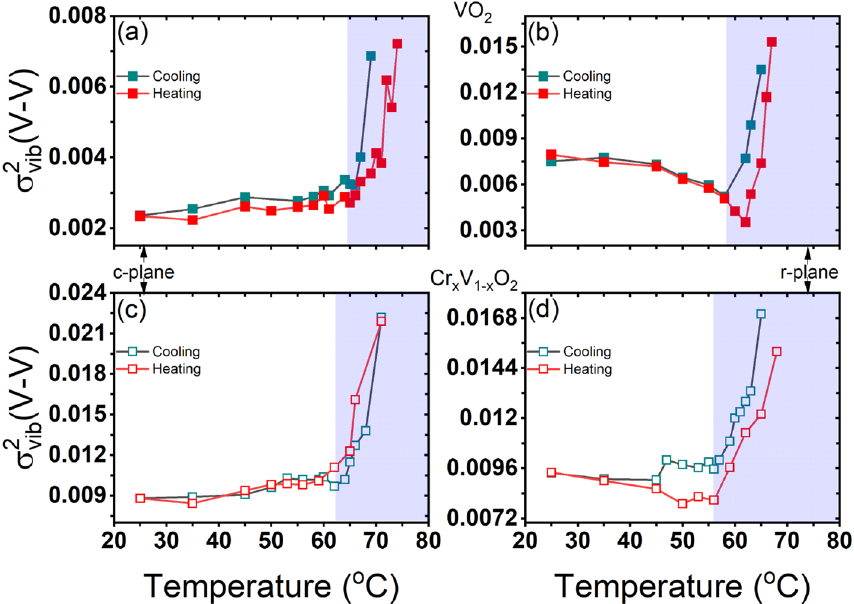
2 ( V − V ) determined from our Raman data which is obtained using the Figure 9. Temperature-dependent σ vib same parameters as in Fig. 8. A negligible fraction contribution is not